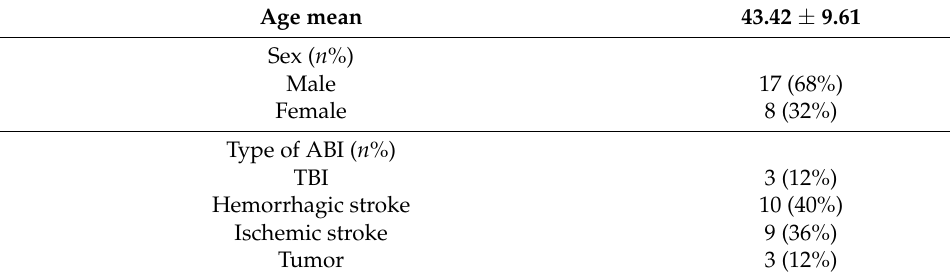
Table 3. Characteristics and clinical scores ( n =